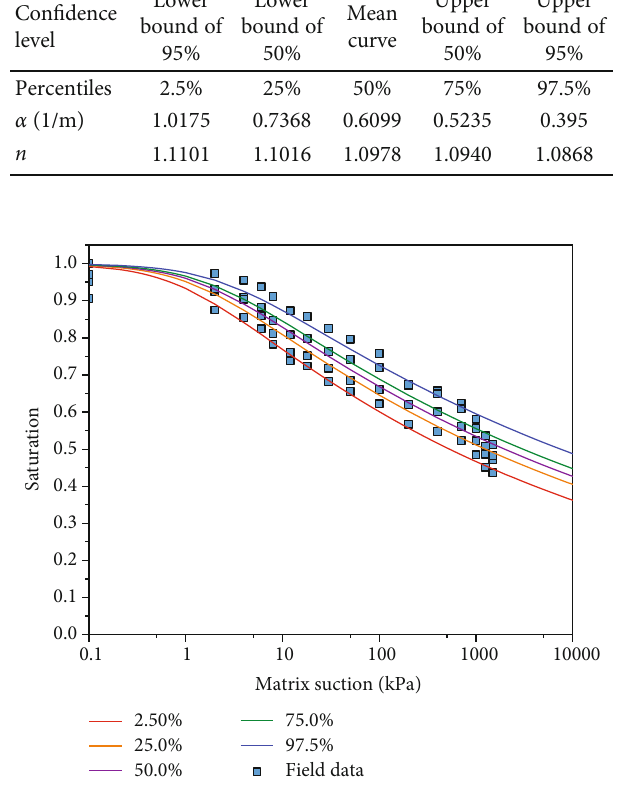
Figure 5: Di ff erent percentiles of parameters of the SWRC